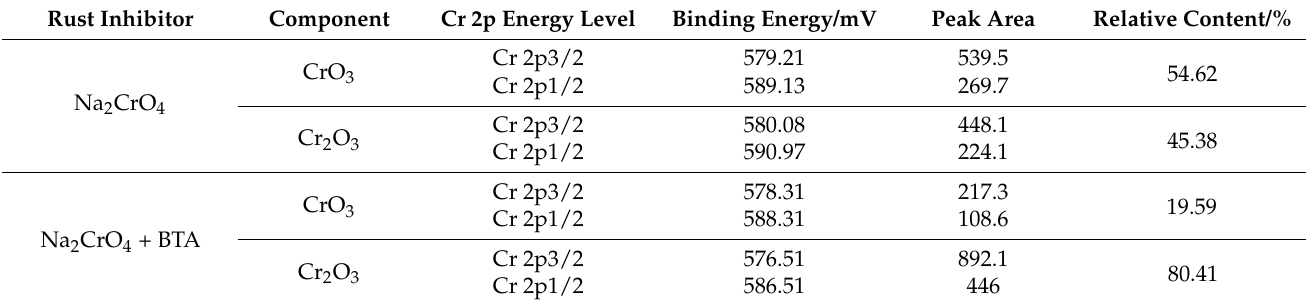
Table 6. Fitting data of the Cr element in different groups.